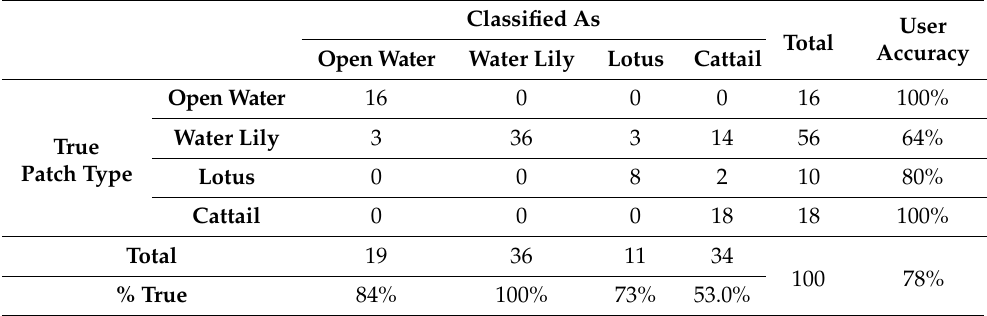
Table 1. Confusion matrix of the WorldView-3 classification result for 2017. The classified result was compared to 100 randomly selected points and classified by visual interpretation and ground-based site knowledge. Classified As User Total AccuracyOpen